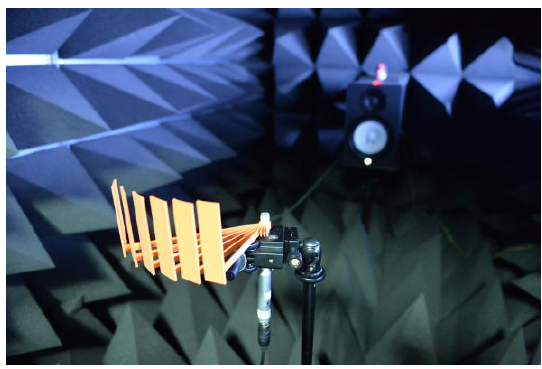
Figure 12. Acoustic experiment in the anechoic chamber with the 3D-printed RML structure.